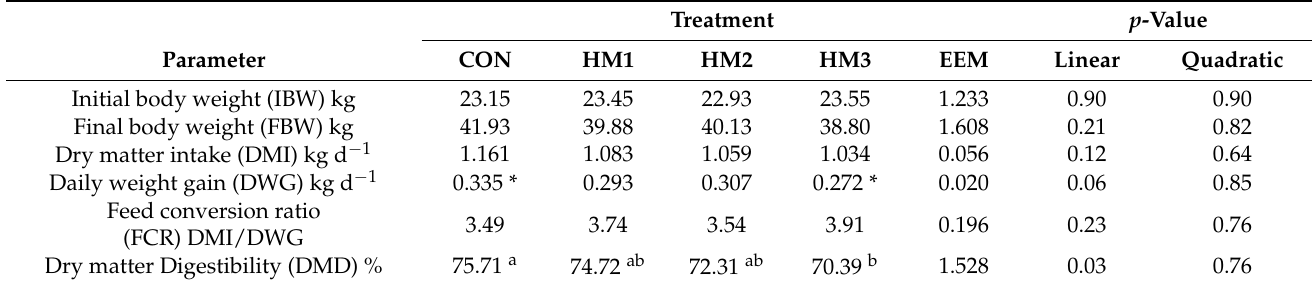
Table 1. Productive performance of lambs supplemented with a polyherbal mixture 1 during the final fattening period. Treatment